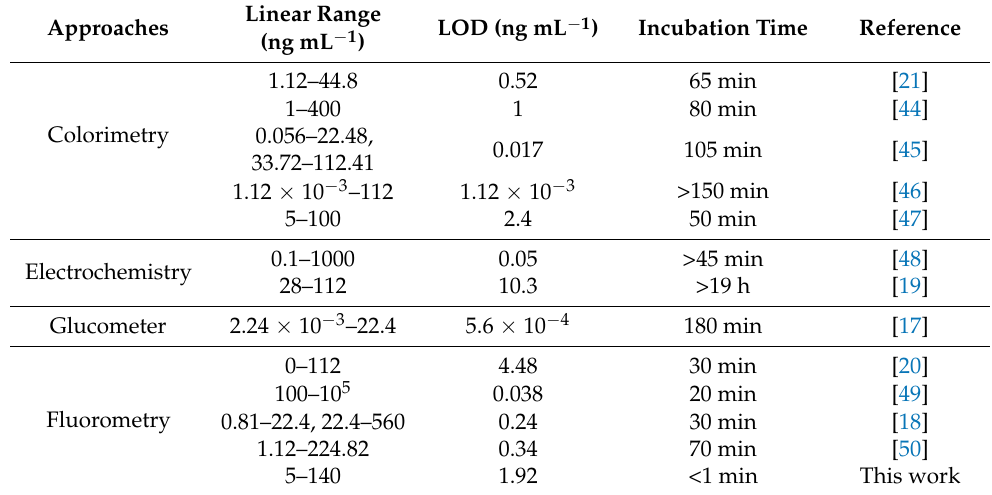
Table 1. Comparison of different aptamer-based approaches for Cd 2+ determination.